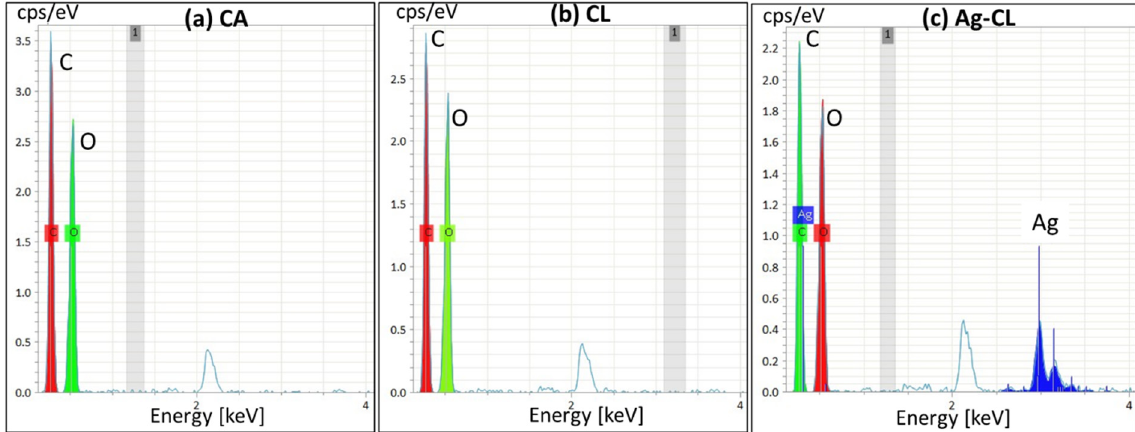
Figure 4. EDS spectra of ( a ) CA, ( b ) CL, and ( c ) Ag-CL nanofibers.